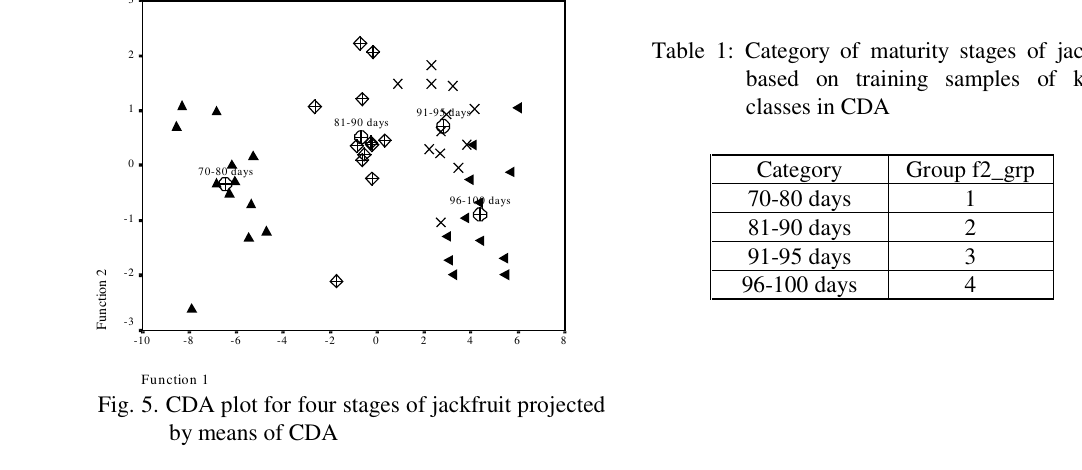
Table 1: Category of maturity stages of